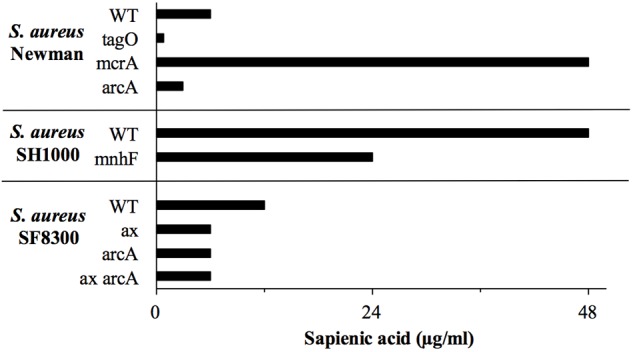
Sapienic acid MICs of S. aureus wild type and mutant strains. MICs were determined using the broth microdilution method. MICs are the lowest concentration found to inhibit growth. Mutants of genes predicted to be important in sapienic acid resistance due to RNA Seq data were contructed or obtained.